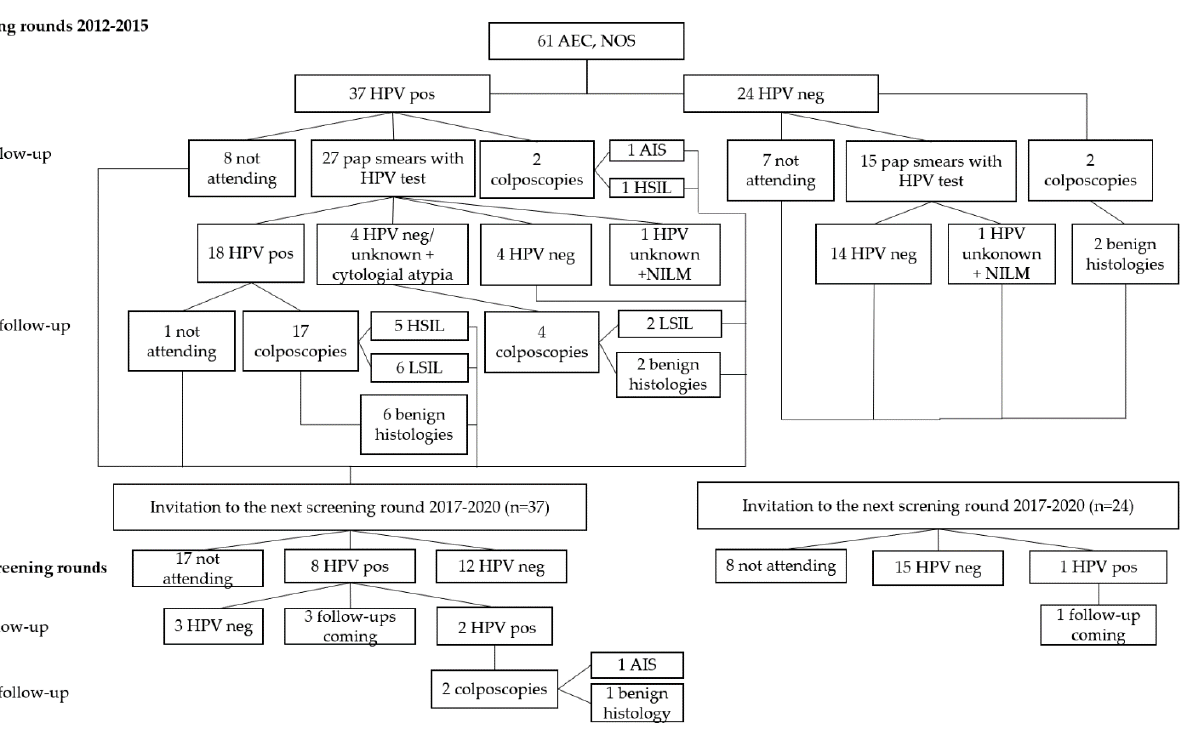
Figure 1. The outcome of two consecutive HPV primary cervical cancer screening rounds of patients with atypical endocervical cells, NOS in cytology. Abbreviations representing cytological diagnoses: AEC, NOS, Atypical Endocervical Cells, NOS; NILM, Negative for Intraepithelial Lesion or Malignancy. Abbreviations representing histological diagnoses: AIS, Adenocarcinoma in Situ; HSIL, High-Grade Intraepithelial Lesion; LSIL, Low-Grade Intraepithelial Lesion; Other abbreviations: HPV, human papillomavirus; pos, positive; neg, negative. Table 1. The high-grade histological lesions detected on the two screening rounds during 2012–2015 and 2017–2020, including the hrHPV genotypes and the initial cytological diagnoses.